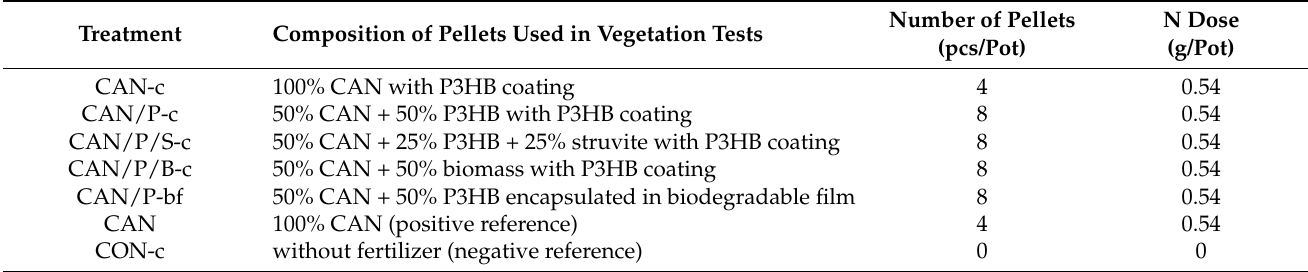
Table 2. Scheme of the pot experiment with